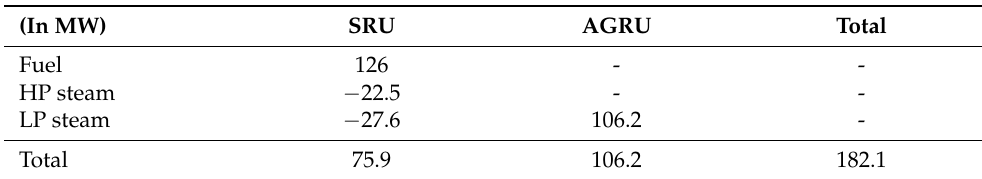
Table 4. Energy consumption of thermal SRU–AGRU.